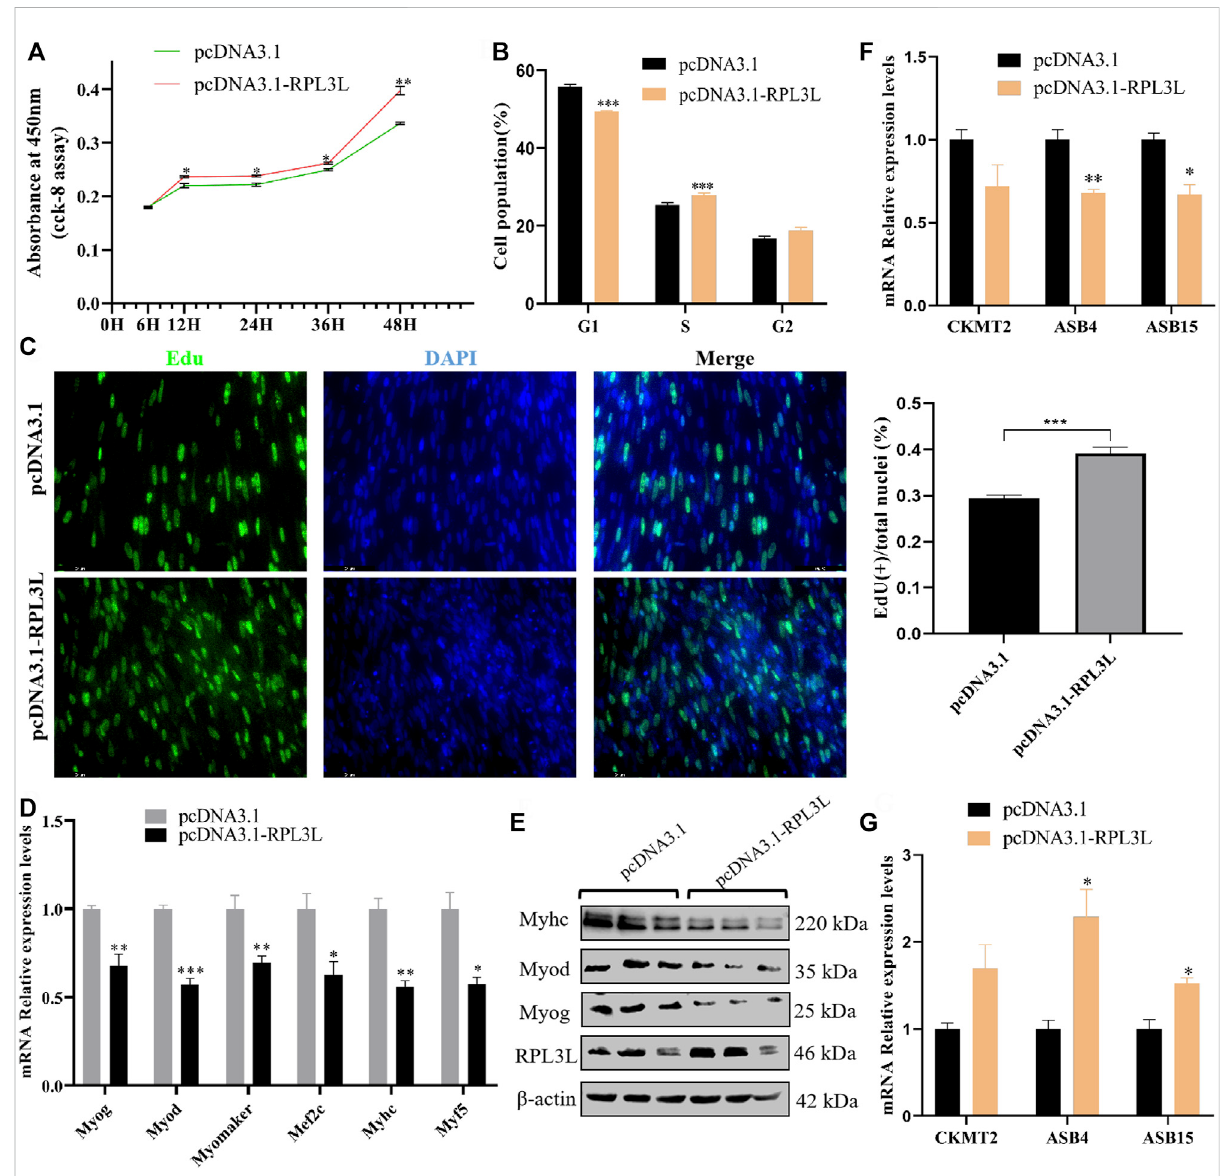
FIGURE 6 RPL3L promotes cellproliferation andinhibitscelldifferentiationofchicken primarymyoblast. (A) CCK-8resultwiththeoverexpressedchicken RPL3L and its negative control; (B) cell cycle assay result after transfecting with the overexpressed chicken RPL3L and its negative control; (C) EdU result with the overexpressed chicken RPL3L and its negative control; (D) mRNA expression levels of differentiation-related marker genes after overexpressing chicken RPL3L ; (E) protein expression levels of differentiation-related marker genes after overexpressing chicken RPL3L ; (F) expression levels of CKMT2 , ASB4 , and ASB15 detected by overexpression of RPL3L in myoblast proliferation stage, respectively; and (G) expression levelsof CKMT2 , ASB4 ,and ASB15 detectedbytheoverexpressionof RPL3L inthemyoblastdifferentiationstage,respectively.ns,notsigni fi cant,* p < 0.05, ** p < 0.01, and *** p <